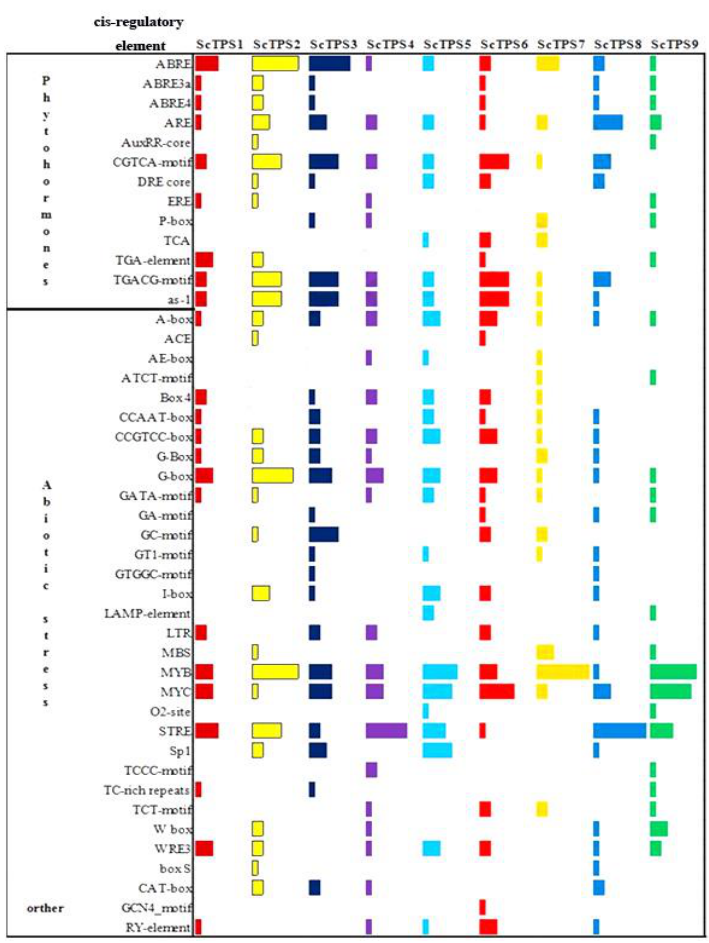
Figure 5. Cis -regulatory elements for the trehalose-6-phosphate synthase ( ScTPS ) gene family in sugarcane. The length of the bar represents the number of elements from 1 to 9. For reference, bars for cis -regulatory element MYB ScTPS8 and ScTPS7 represent 1 and 9 elements,